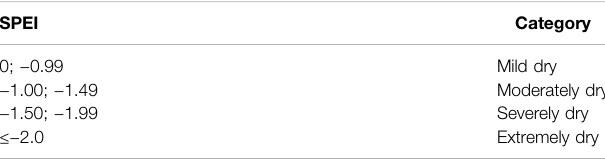
TABLE 1 | Drought classi fi cation based on standardised precipitation evapotranspiration index (SPEI) values according to the classi fi cation proposed by McKee et al.